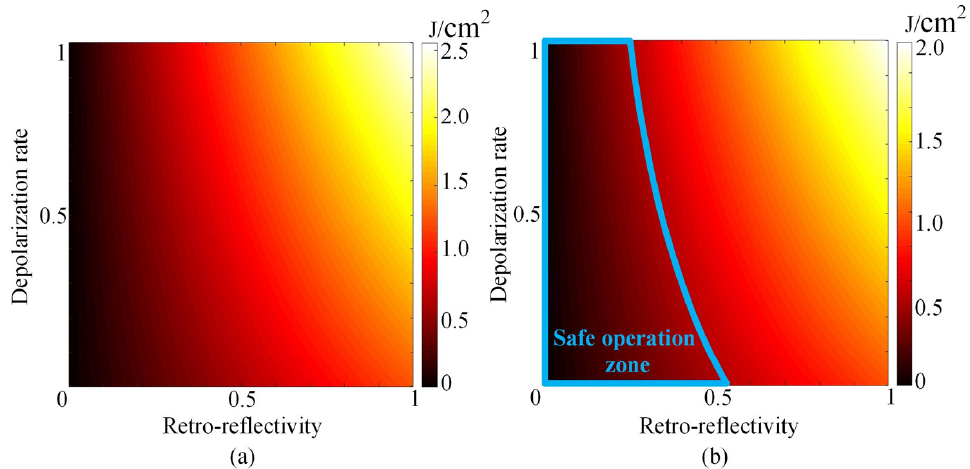
Figure 3. T The energy densities of the retro-reflected pulse ( a ) on the BM7 and ( b ) on the front end. For safe operation, the energy density on the front end is lower than 0.5 J/cm 2 , which is the threshold of a Faraday isolator at the end of the front end. The safe operation zone is shown inside the blue lines in Figure 3b. The figure shows that the operation is safe when the retro-reflectivity is lower than 25%, regardless of the value of the depolarization rate. If the retro-reflectivity is lower than 53%, the operation is safe as well. The conditions beyond the blue lines in Figure 3b exceed the design of XG-III and rarely occur, so it is almost totally safe for the front end in